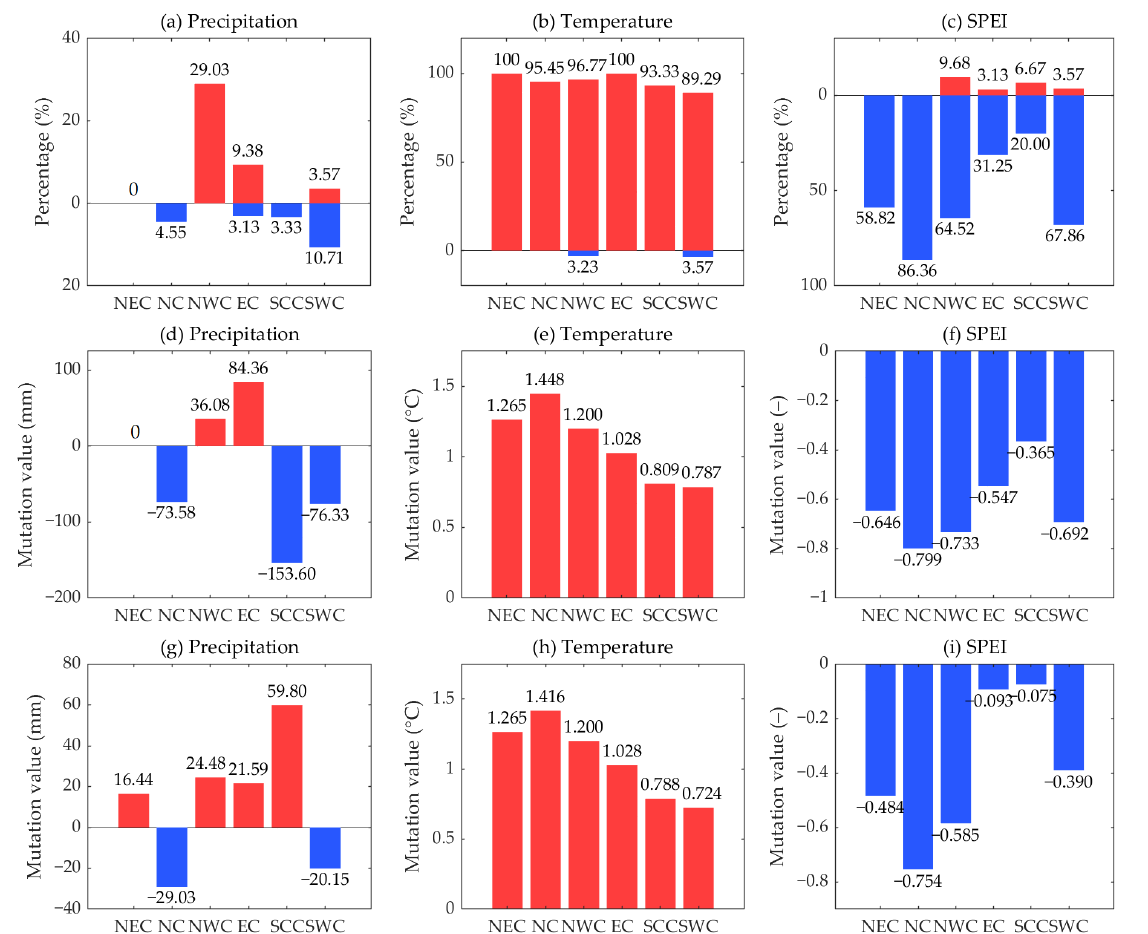
Figure 5. Percentage of stations with significant breakpoints to the total number of stations in the sub-regions during 1951–2021: ( a ) precipitation; ( b ) temperature; and ( c ) the SPEI. Red refers to an increase in means after a significant mutation (above x-axis); blue refers to a decrease in means after a significant mutation (below x-axis). Average difference (jump of means) between post- and pre-mutation for stations with significant breaks in the sub-regions: ( d ) precipitation; ( e ) temperature; and ( f ) the SPEI. Average difference (jump of means) between post- and pre-mutation for all stations in the sub-region: ( g ) precipitation; ( h ) temperature; and ( i ) the SPEI. Red (blue) denotes an increase (a decrease) for post- compared to pre-mutation. Subfigures ( d – f ) consider statistically significant breakpoints at the 95% confidence level; Subfigures ( g – i ) consider breakpoints for all stations in the